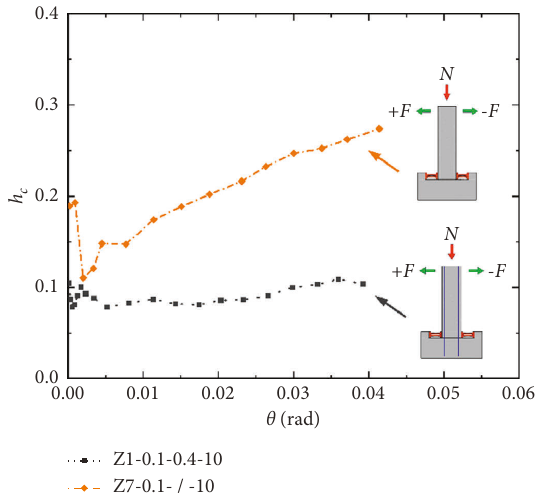
Figure 20: Comparison of cumulative energy dissipation coeffi- cient ζ curves of RED-HRC and